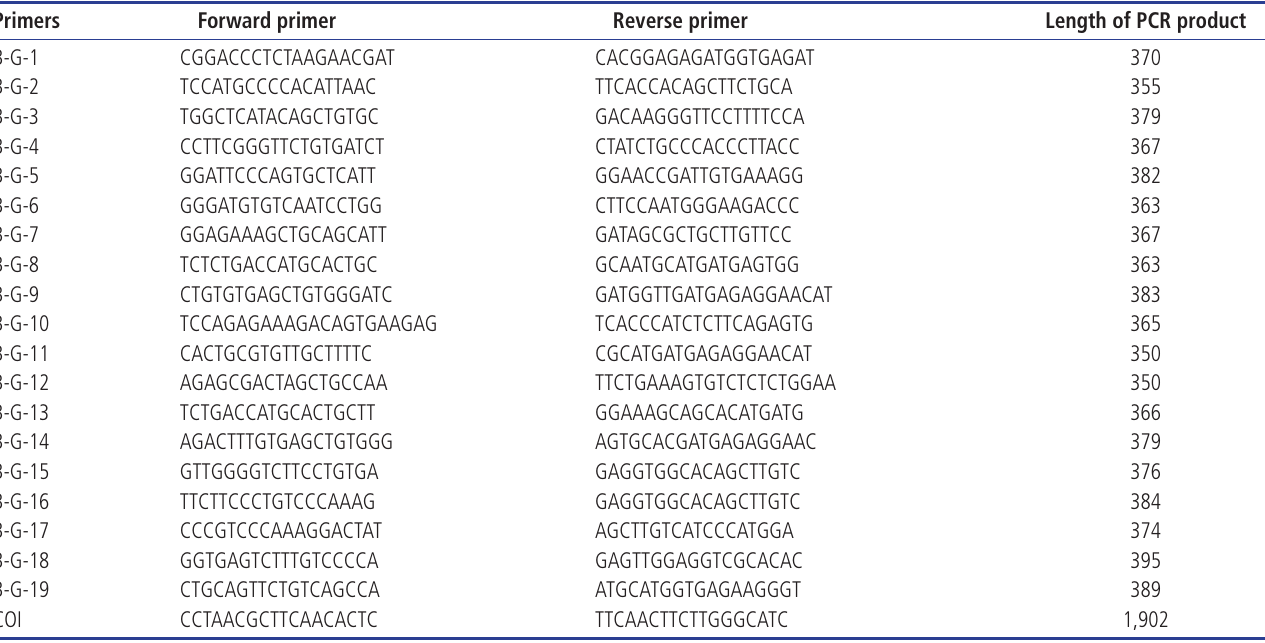
Table 1. Primers for sequencing of the chicken MHC B-G gene (NW_003763992) Primers